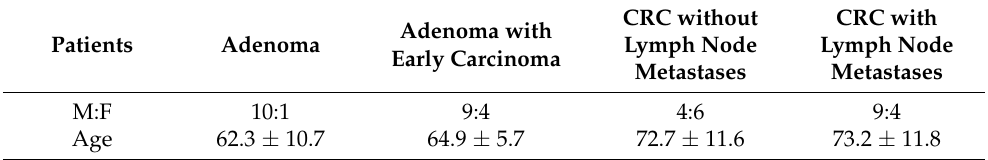
Table 4. Characteristics of the included